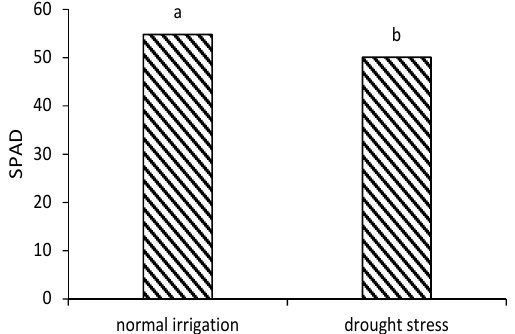
Fig 3. Effect of irrigation regimes on SPAD. Means by the uncommon letter in each column are significantly different according to Duncan test (p<0.05).